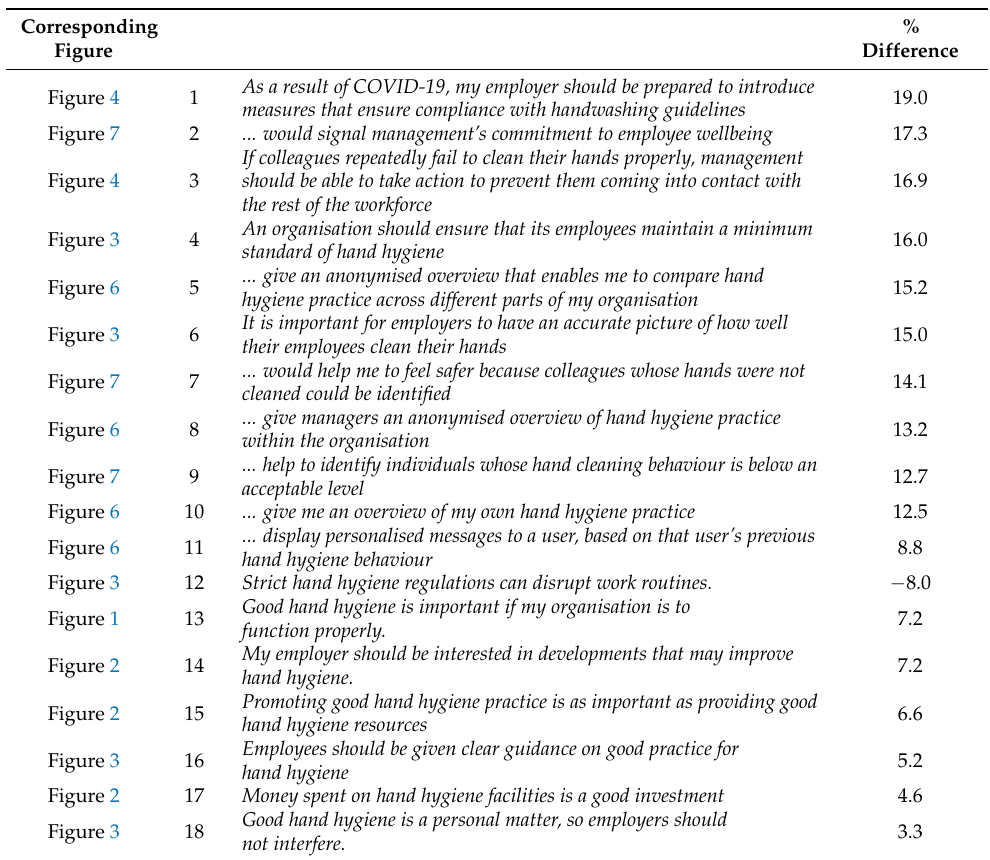
Money spent on hand hygiene facilities is a good